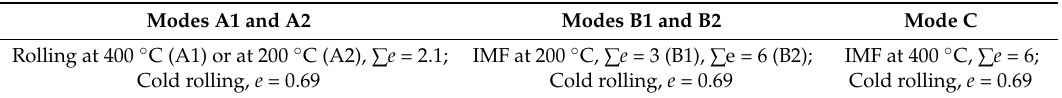
Table 3. Thermomechanical treatment types.